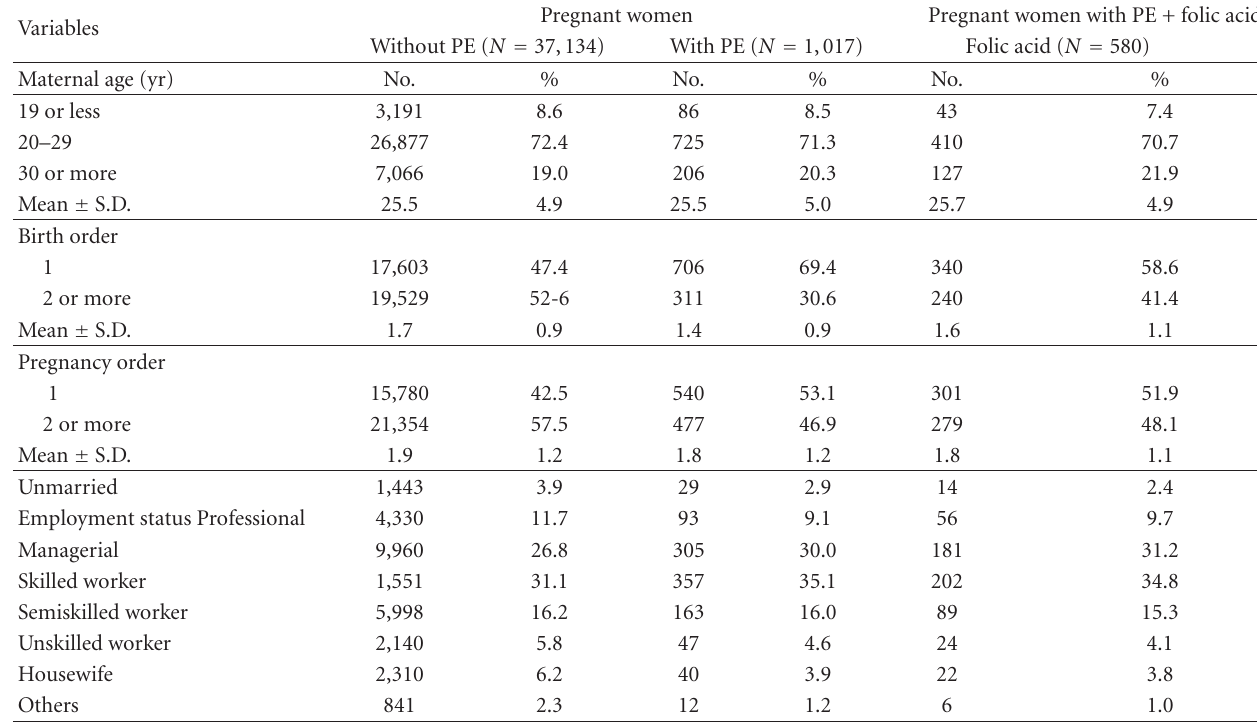
Table 1: Characteristics of pregnant women without pre-eclampsia (PE) as a reference and with PE, in addition pregnant women with PE supplemented with folic acid.